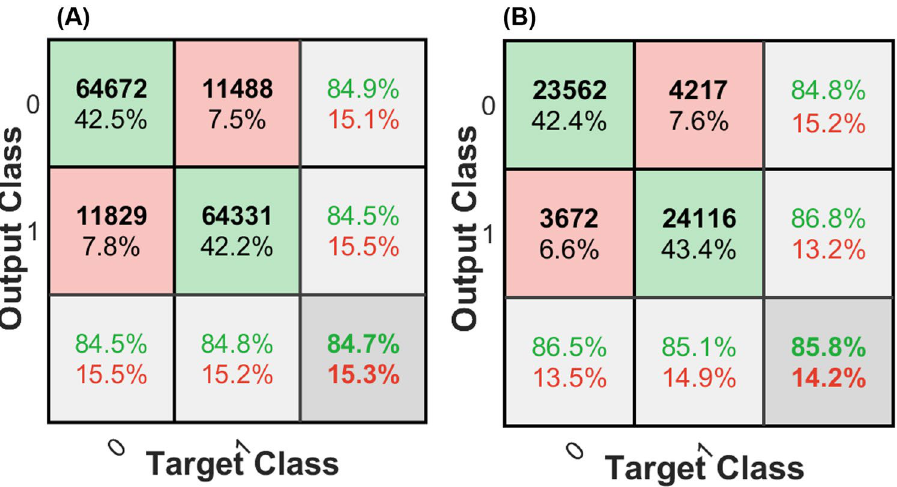
Figure 7. Confusion matrices corresponding to the testing data used to distinguish class 0 (efferent) from class1 (afferent) ENG data: (A) Model 1 and (B) Model 2. Both figures illustrate a high performance of both models in detecting efferent or afferent data and there is a close balance on performance that confirms the generalization and robustness of both models. The last row and column of each confusion matrix shows the recall and precision per class, respectively.